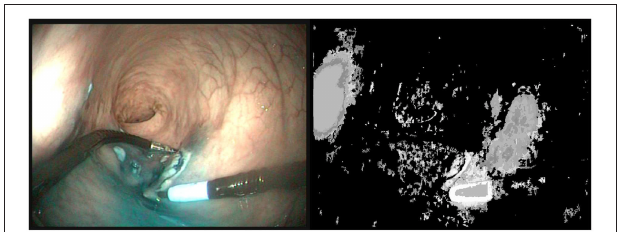
FIGURE 1 | (Left) Last image of a 50 images sequence (5s) where the right instrument is moving. (Right) Segmentation provided by VideoPCA (Stretcu and Leordeanu, 2015). The salient part of the instrument near the tip is well extracted but a large part of the background is also considered as foreground. Moreover, despite the motion of the instrument, the shaft of the instrument is not considered as